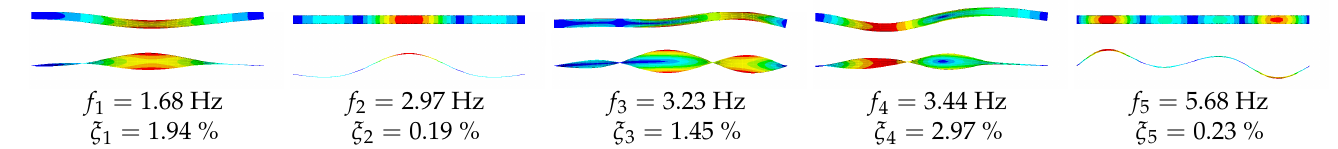
Figure 14. Top and side view, eigenfrequency and damping ratio of the first five modes of the Eeklo footbridge, after [17].